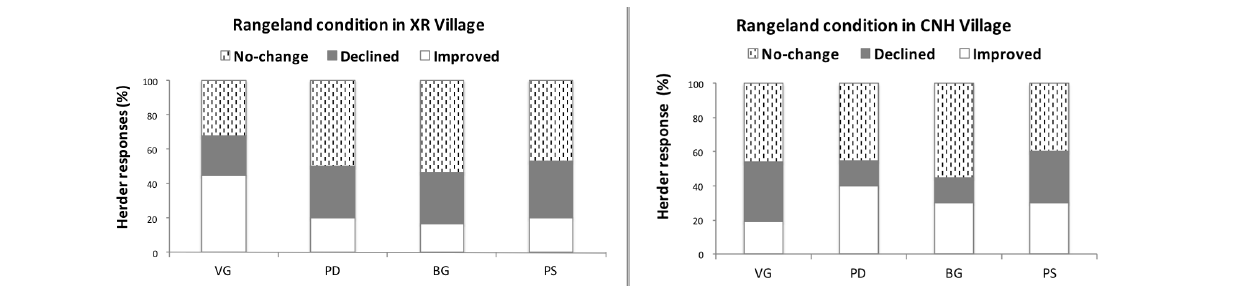
Fig. 4 . Herder perceptions of changes in vegetation growth (VG), pika disturbance (PD), bare ground (BG), and poisonous species (PS) in XR and CNH Villages from 2009 to 2014.